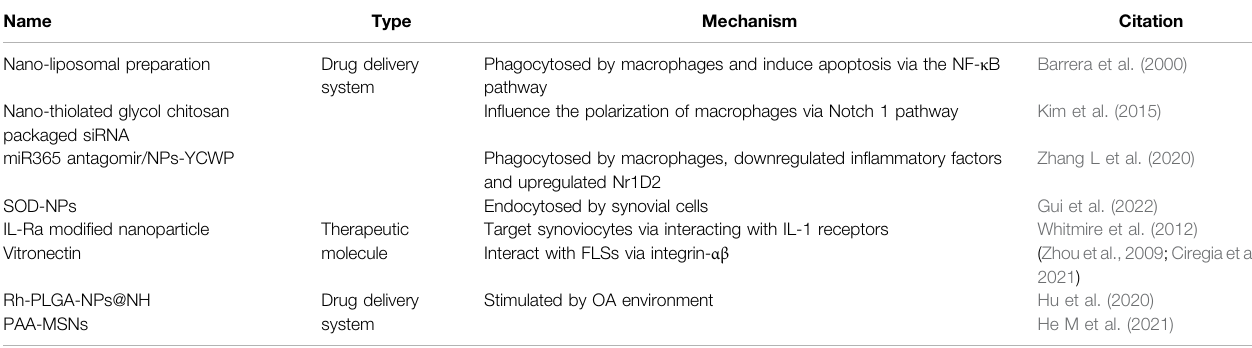
TABLE 3 | Synovium targeted